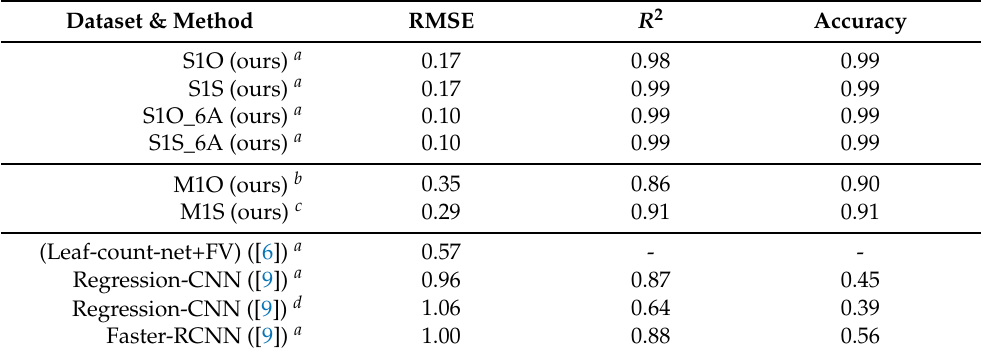
Table 2. Performance comparison between our and existing methods on S1 and M1. Dataset & Method